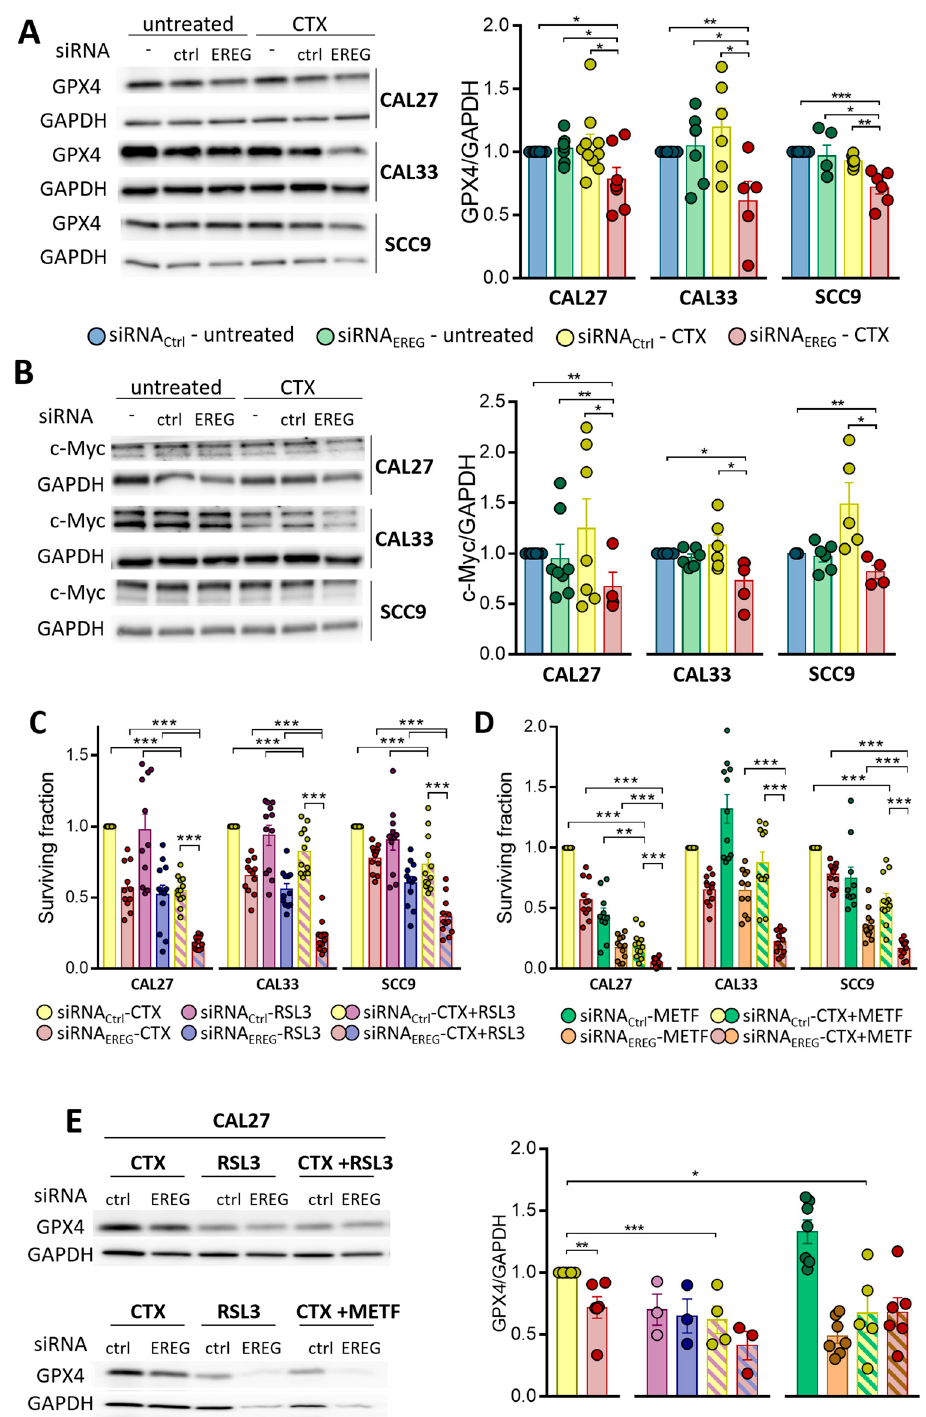
Figure 4. Expression of GPX4 and GAPDH ( A ) and c-Myc and GAPDH ( B ) was determined by Western blot in CAL27, CAL33 and SCC9 cells untransfected or transfected with siRNA Ctrl or siRNA EREG and treated with solvent or 30 nM CTX. Histograms represent the mean ± SEM (CAL27 and CAL33 n = 10 and SCC9 n = 9, with * p < 0.05, ** p < 0.01 and *** p < 0.001) of the protein expression normalized with GAPDH. ( C ) Histograms show the surviving fraction of CAL27, CAL33 and SCC9 cells transfected with siRNA Ctrl or siRNA EREG and treated with 30 nM CTX, 5 µM RSL3 or a combination of both. Data represent the mean ± SEM surviving fraction at day 8 post-transfection and post-treatment ( n = 4, with *** p < 0.0001). ( D ) Histograms show the surviving fraction of CAL27, CAL33 and SCC9 cells transfected with siRNA Ctrl or siRNA EREG and treated with 30 nM CTX, 1 mM metformin (METF) or a combination of both. Data represent the mean ± SEM surviving fraction at